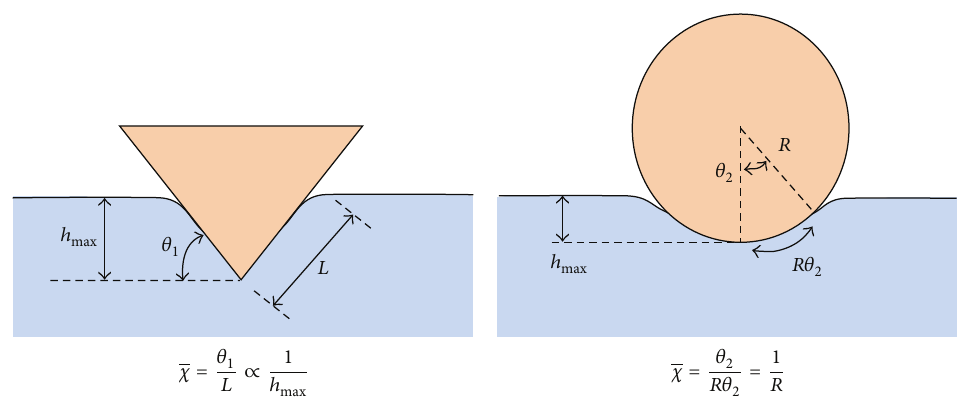
Figure 28: Dependence of strain gradient 𝜒 on ℎ max for different tip geometries [65, 66].